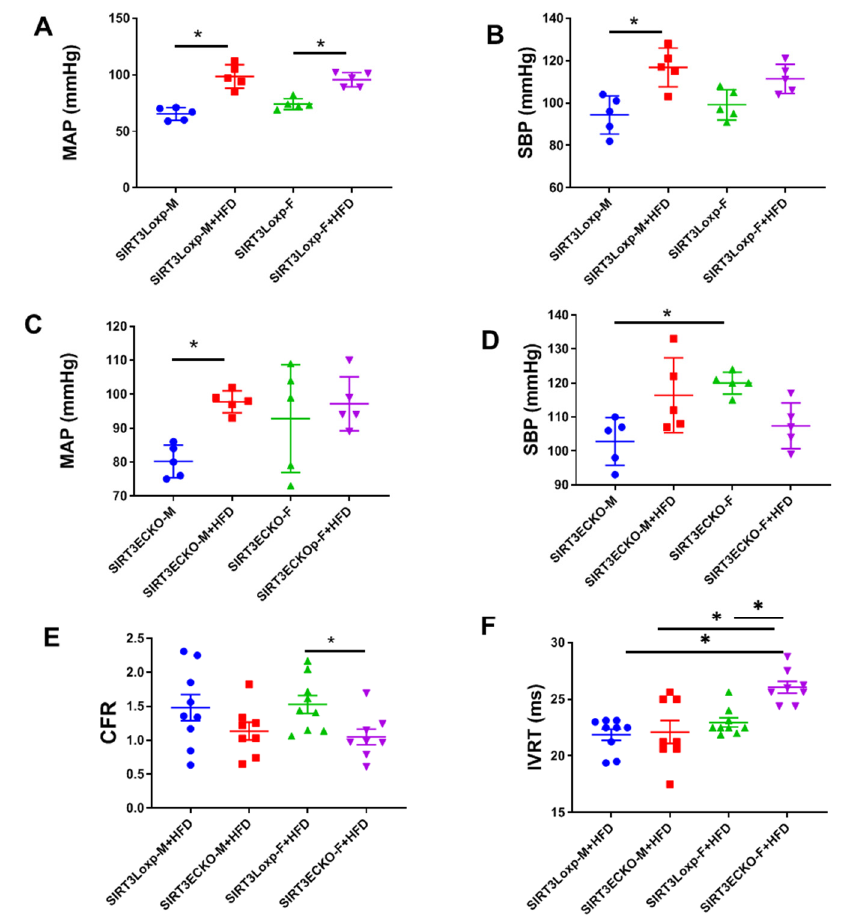
Figure 5. The role of endothelial SIRT3 deficiency on sex differences in HFD-induced cardiovascular dysfunction. ( A , B ) HFD increases the blood pressure in both male and female control SIRT3 LoxP mice. ( C , D ) HFD does not further increase blood pressure in female SIRT3 ECKO mice as observed in the male SIRT3 ECKO mice. N = 5 mice. * p < 0.05 ( E , F ) Female SIRT3 ECKO mice fed an HFD exhibit impaired CFR and diastolic dysfunction when compared to the female SIRT3LoxP mice. The HFD decreases CFR and increases IVRT in the female SIRT3 ECKO mice but not in the male SIRT3 ECKO mice fed an HFD. N = 8–9 mice. * p < 0.05